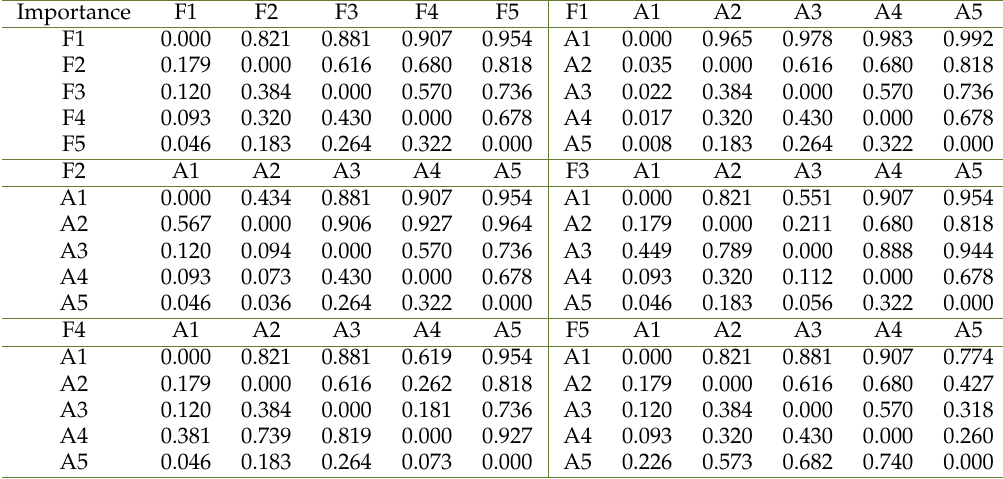
Table 3. AHM Scoring Matrix.